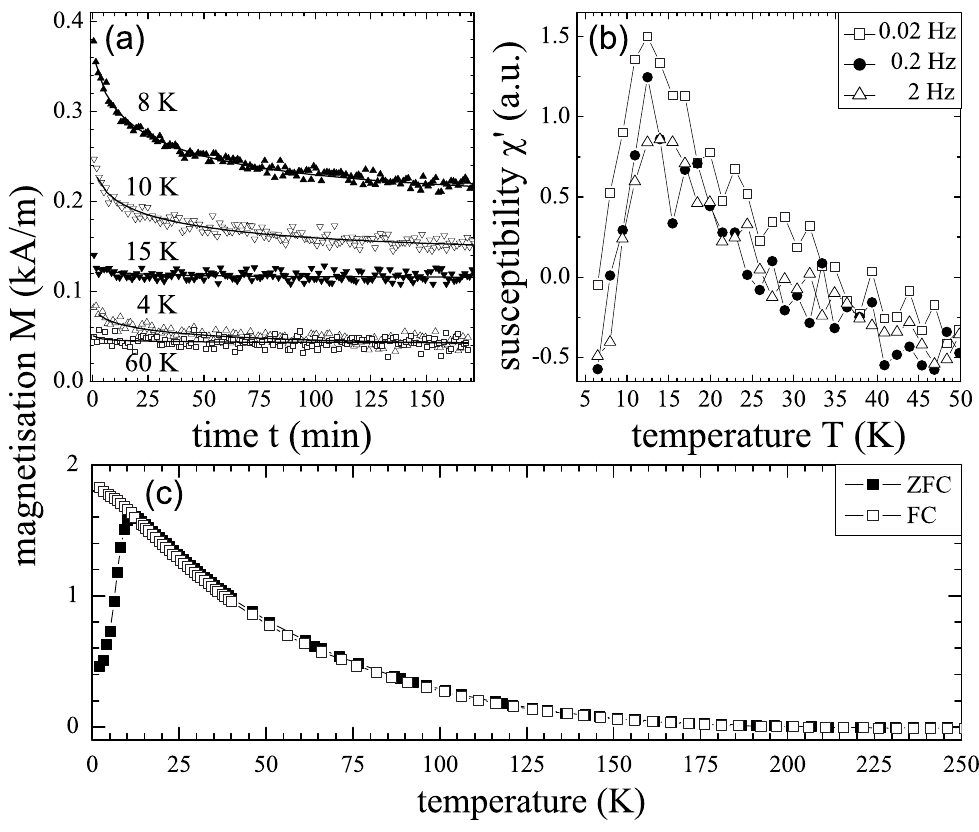
Figure 8 . (a) Relaxation of the magnetization of Ge field at different temperatures. Solid lines represent fits to a stretched exponential decay. (b) Temperature-dependent real part of the ac susceptibility measured at different frequencies. (c) FC or ZFC temperature-dependent magnetization in a field of 0.1 T. (Reprinted with permission from Ref. [34]. Copyright 2006 by the American Physical